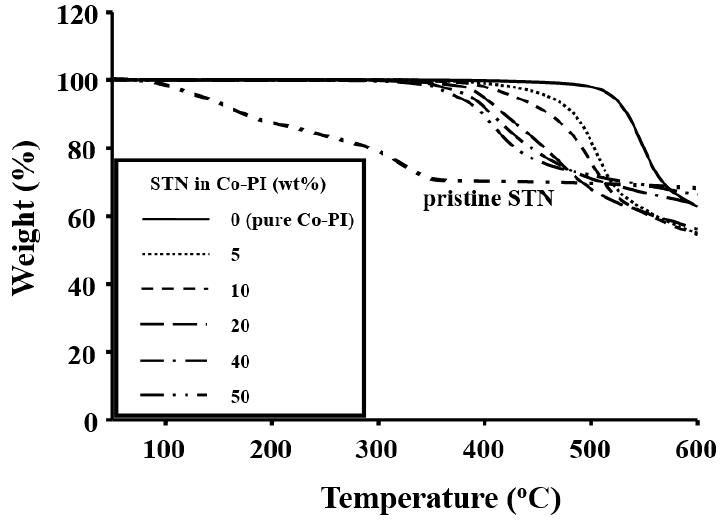
Figure 9. TGA thermograms of STN and Co-PI hybrids with various STN concentrations.